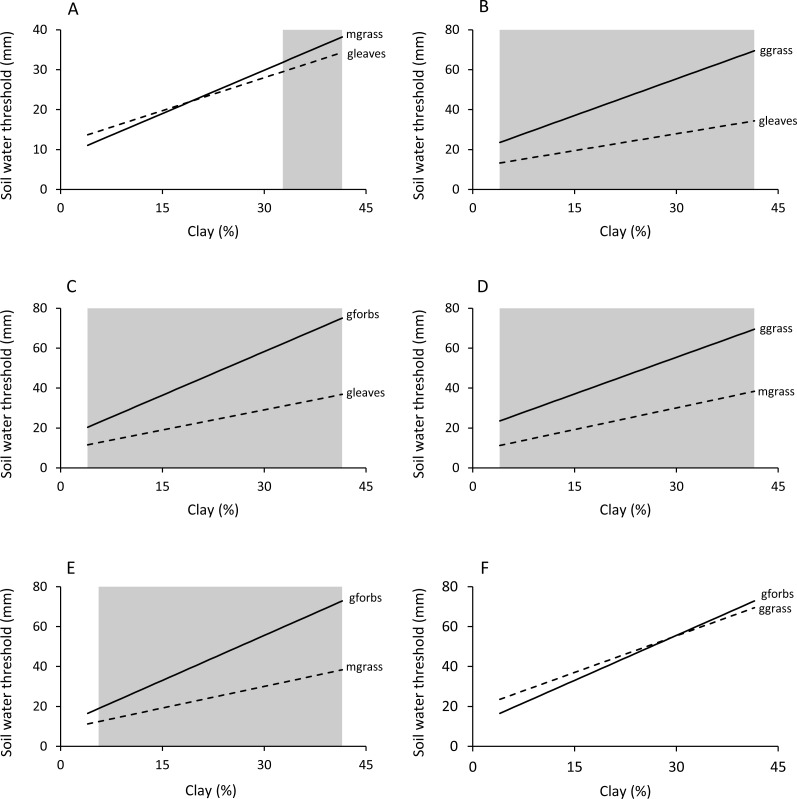
Effect of soil clay content and food type on green-up (M1) soil water thresholds.Regions of significant (P < 0.05) differences between green leaves and mixed grass (A), green leaves and green grass (B), green leaves and green forbs (C), mixed grass and green grass (D), mixed grass and green forbs (E), and green grass and green forbs (F) are shaded grey.